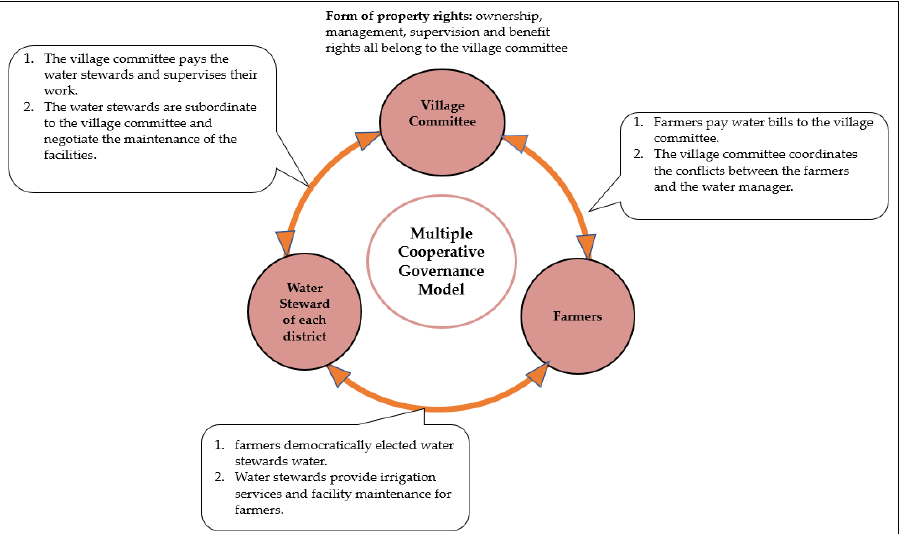
Figure 1. Governance logic diagram of the “ multiple cooperative governance ” model.